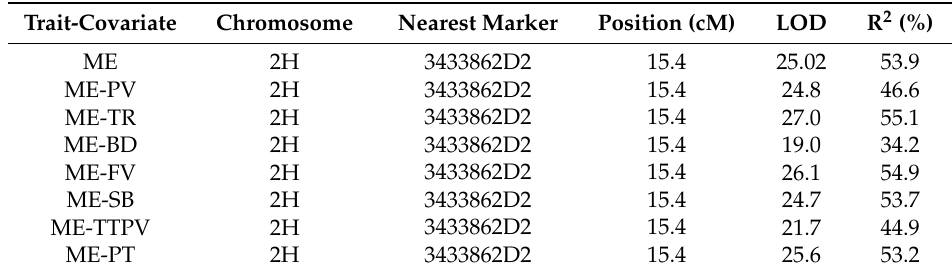
Table 5. QTL analysis for malt extract using different pasting properties as covariates.